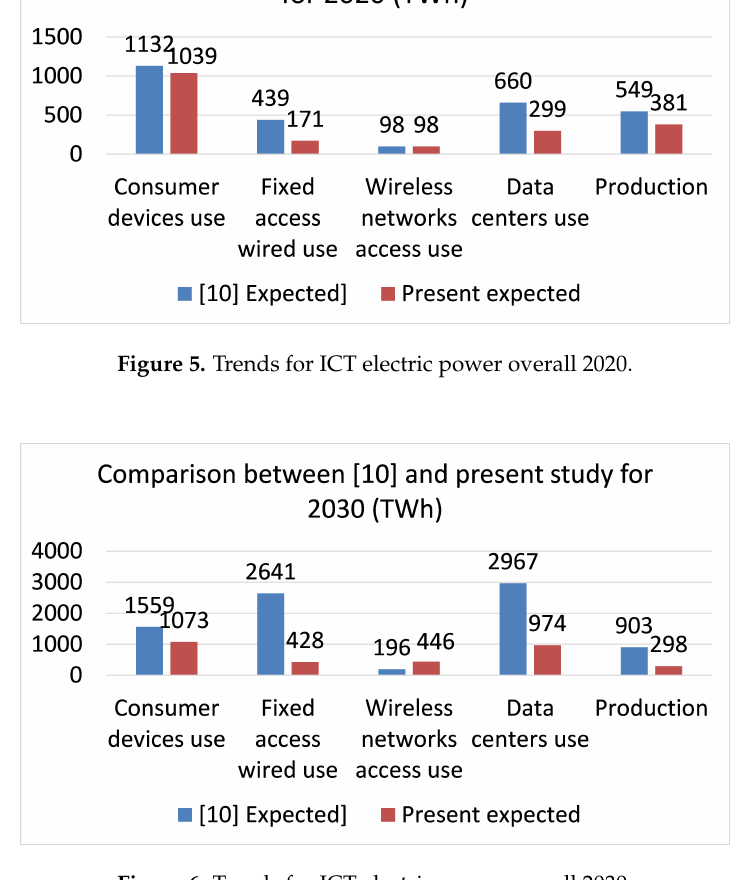
Figure 6. Trends for ICT electric power overall